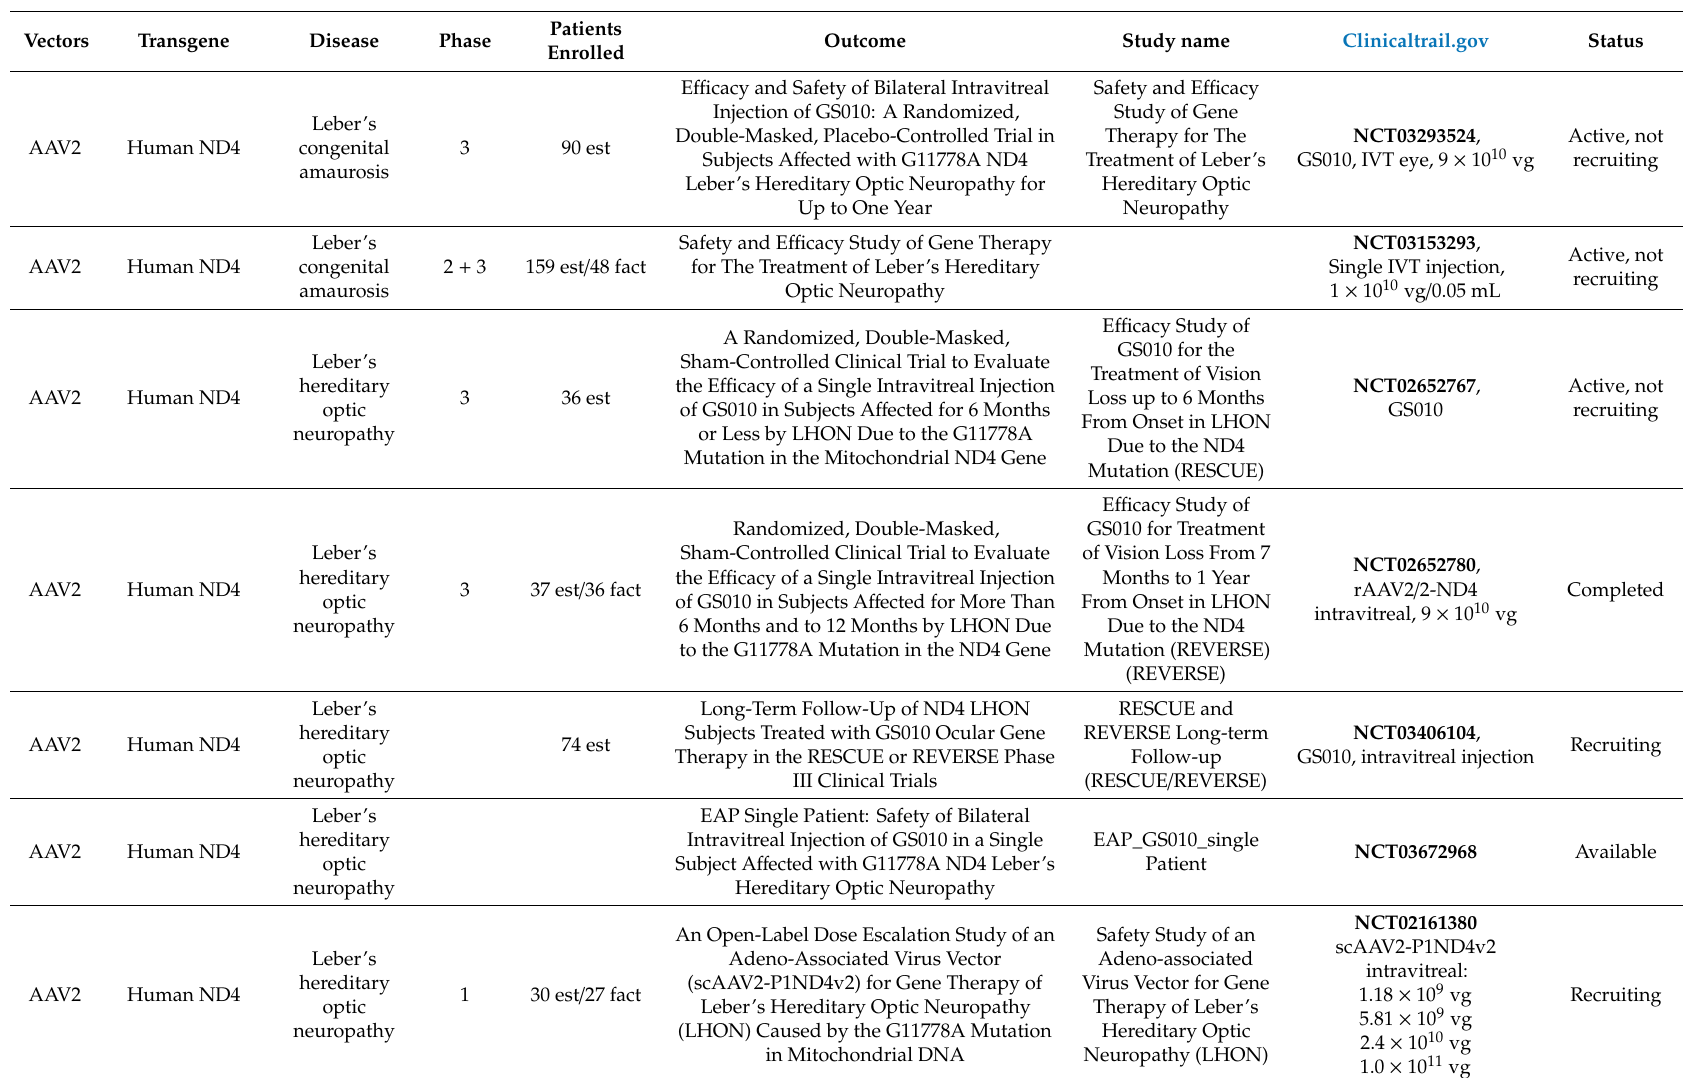
E ffi cacy and Safety of Bilateral Intravitreal Injection of GS010: A Randomized, Double-Masked, Placebo-Controlled Trial in Subjects A ff ected with G11778A ND4 Leber’s Hereditary Optic Neuropathy for Up to One Year